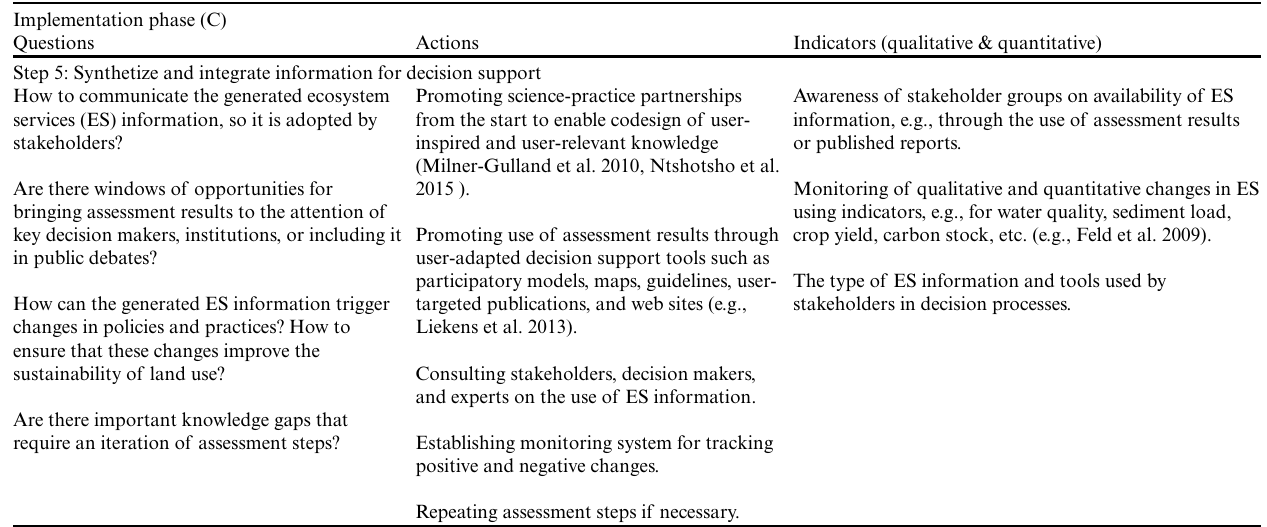
Table 3 . Examples of questions, actions, and indicators for implementation phase